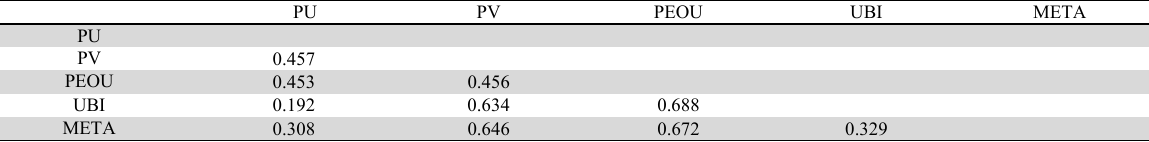
Correlation Results (HTMT).